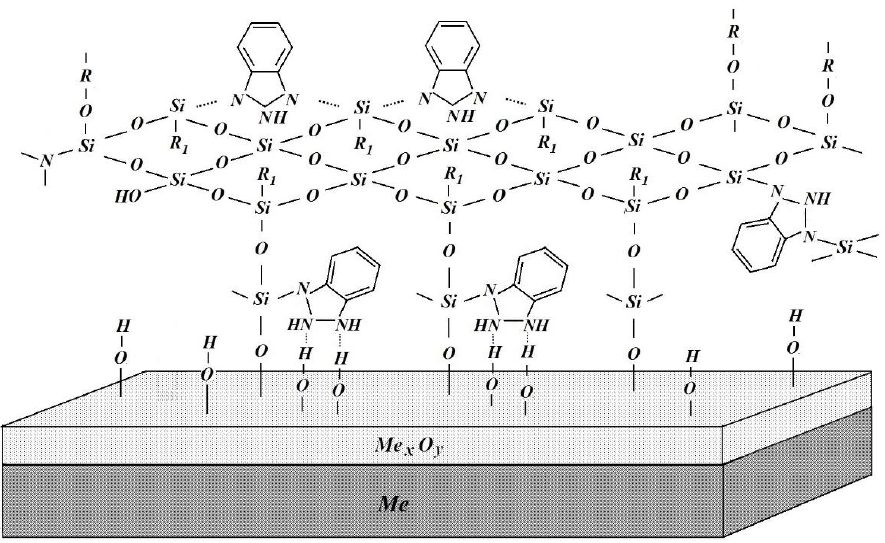
Figure 13. Structure of a siloxano-azole nanolayer on carbon steel surface.